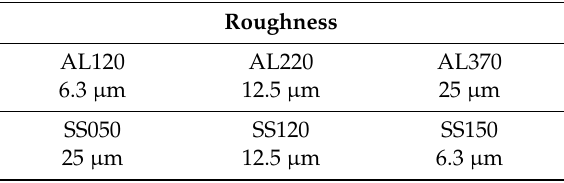
Table 2. Declared roughness of individual samples.